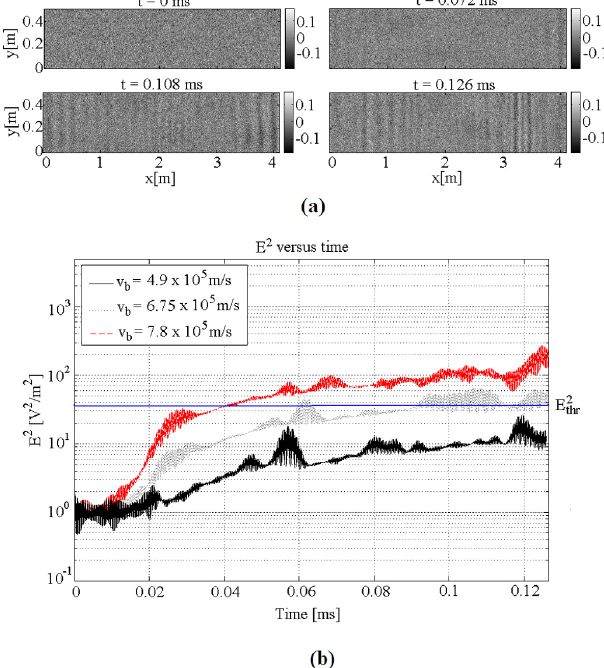
Fig. 7. (a) Snapshots of the ion density variation for simulations with parameters presented in Sect. 3.2 for v b = 6 . 75 × 10 5 ms − 1 . The ion density variation associated with v b = 7 . 8 × 10 5 ms − 1 is shown in Fig. 3b. The beam with velocity v b = 4 . 9 × 10 5 ms − 1 does not triger the decay; therefore, the ion density variation has a noise-like appearence being omitted for this reason. (b) Simulated magnitude squared electric field ( E 2 t ) versus time for simulations with parameters presented in Sect. 3.2.